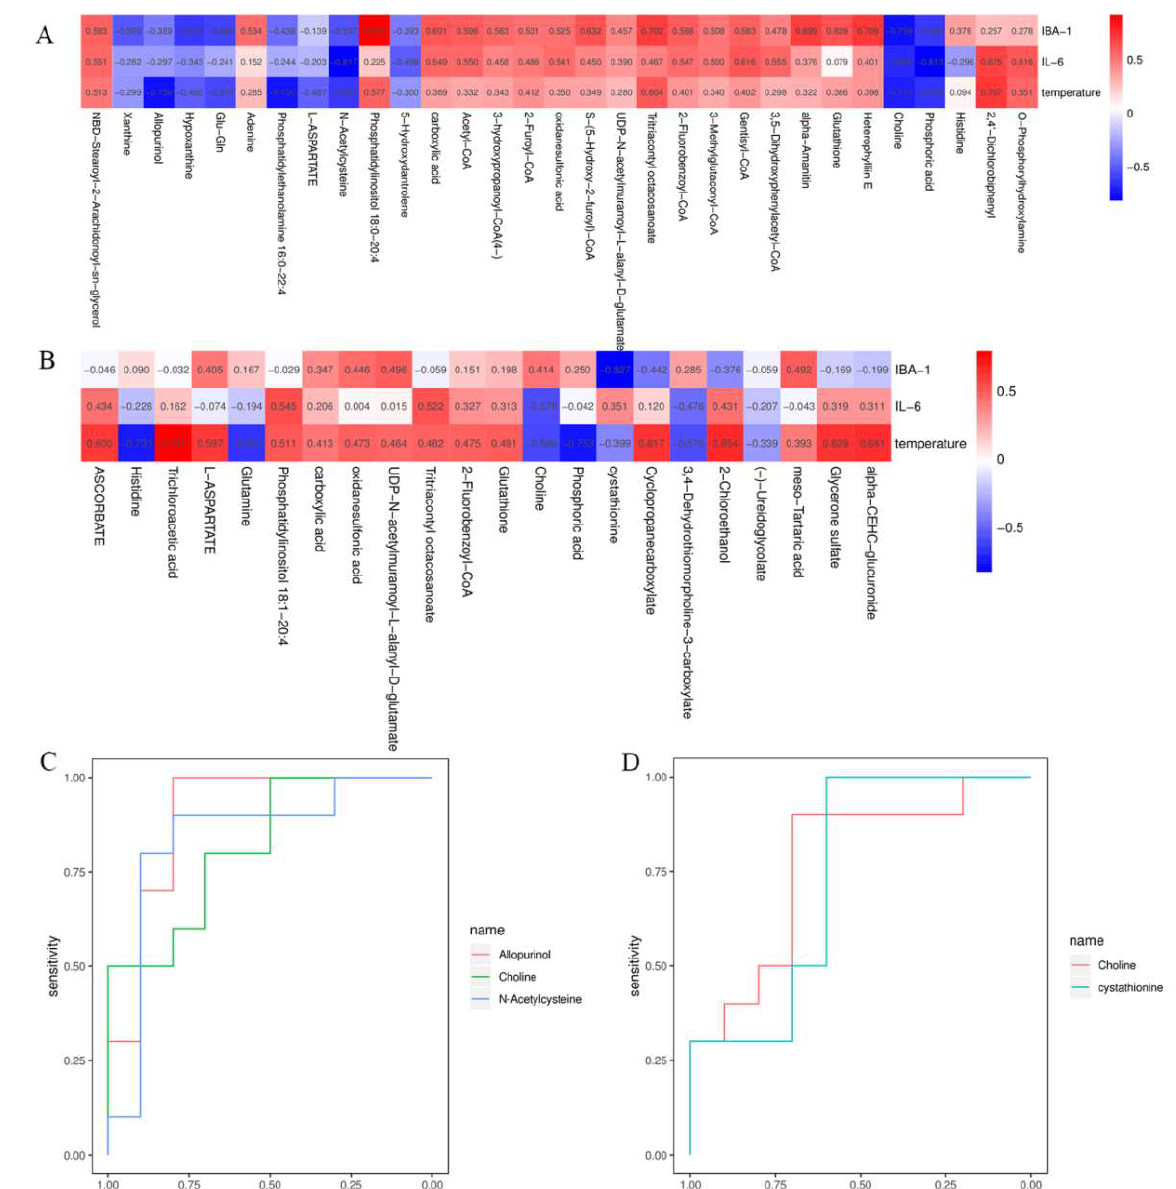
Figure 6. Verification of potential biomarkers. ( A ) The correlations of potential biomarkers between CON group and GHRS group, n = 6. ( B ) The correlations of potential biomarkers between GHRS group and GHRS + REA group, n = 6. ( C ) The ROC curve of early biomarkers for CON group and GHRS group, n = 6. ( D ) The ROC curve of early biomarkers for GHRS group and GHRS + REA group, n = 6.